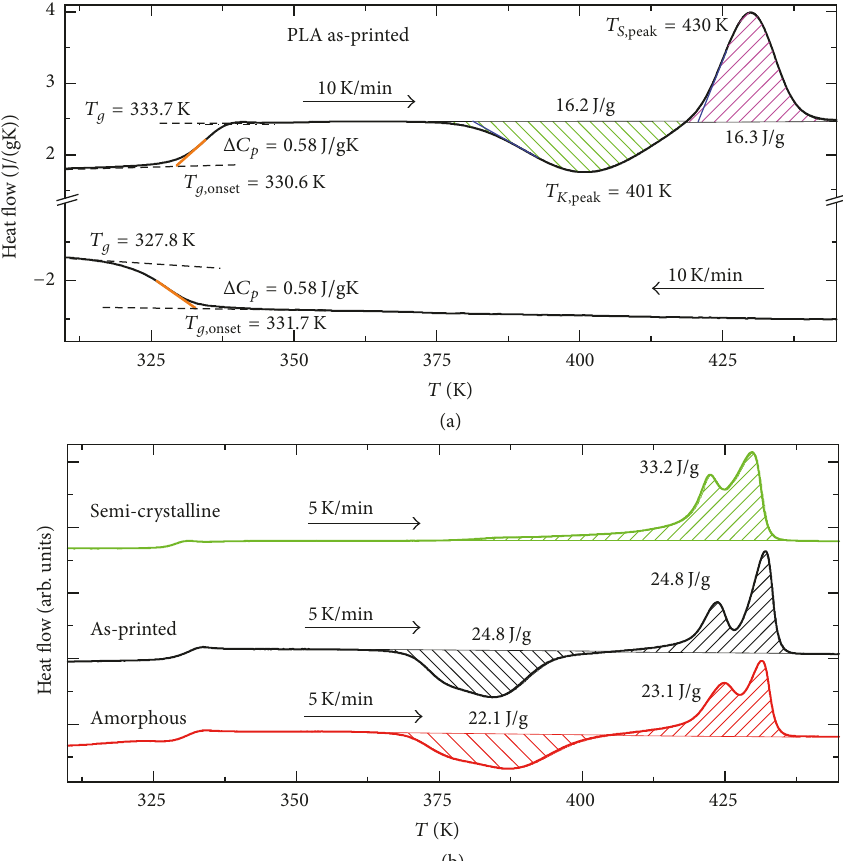
Figure 1: (a) Heat flow (endotherms up) of initial heating and subsequent cooling traces of PLA in the “as-printed” condition at a rate of 10K/min. The glass transition temperature is determined using both the half step size ( 𝑇 𝑔 ) and onset temperature ( 𝑇 𝑔, Onset ) methods. (b) DSC heating traces at a rate of 5 K/min, comparing PLA in the three conditions: semicrystalline (green), as-printed (black), and amorphous (red) conditions. The measurements are shifted vertically for